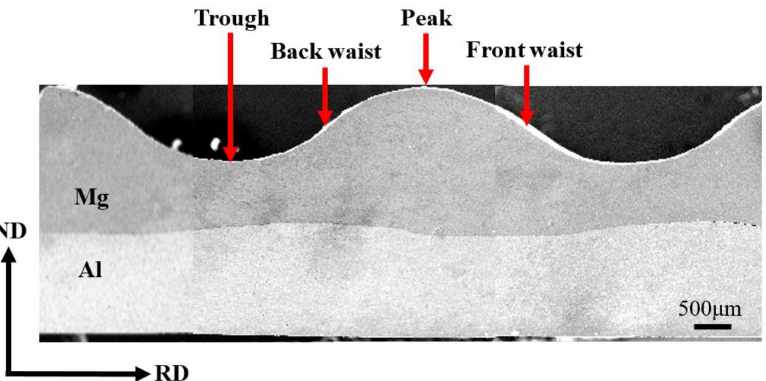
Figure 3. Interface macro-morphology and typical positions of the corrugated Mg/Al clad